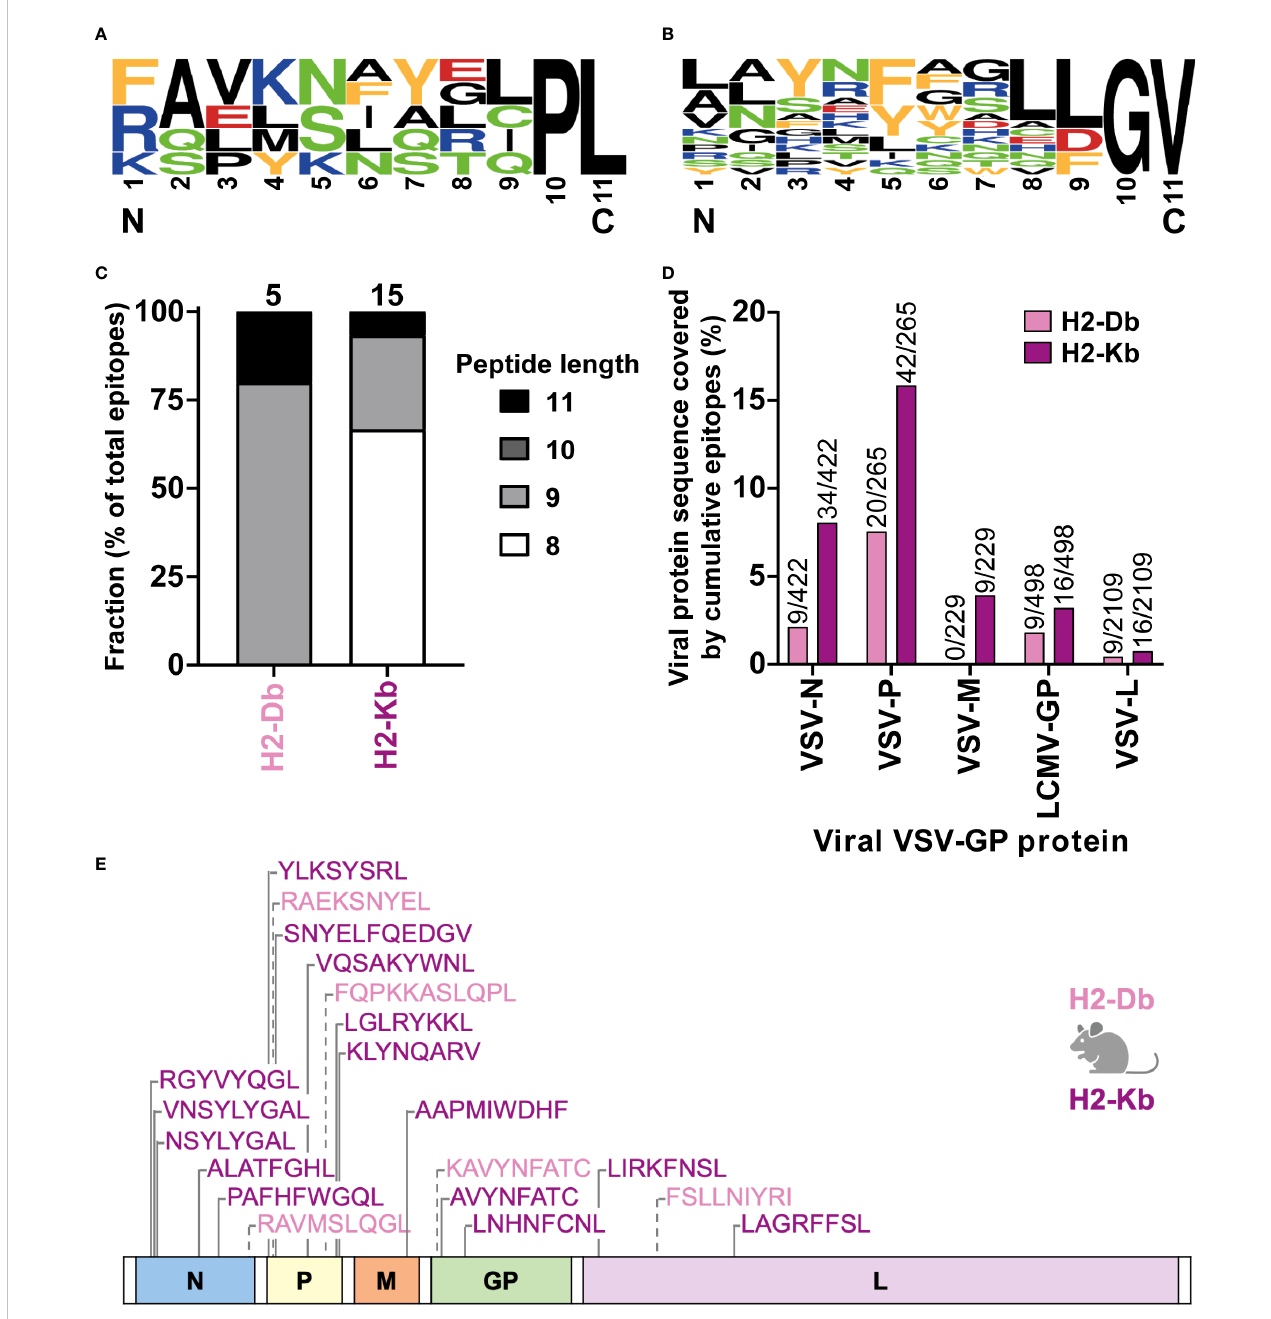
FIGURE 6 H2-Db and H2-Kb presented VSV-GP T cell epitopes differ in peptide sequence logos, peptide length, and viral protein immunogenicity but not in distribution across VSV-GP proteome. (A, B) Sequence logos of fi ve H2-Db presented VSV-GP epitopes (A) and fi fteen H2-Kb presented VSV-GP epitopes (B) . Letter size indicates the frequency of the AA at that position. Positively charged AAs are indicated in blue, negatively charged AAs in red, aromatic AAs in yellow, polar AAs in green, and non-polar AAs in black. (C) Relative distribution of peptide lengths plotted per MHC-I allele for all identi fi ed VSV-GP T cell epitopes. Numbers above bars represent total identi fi ed epitopes per MHC-I allele. (D) Viral protein sequence covered by the identi fi ed epitopes. Numbers above bars represent summed AAs covered by identi fi ed epitopes divided by the viral protein AA length. (E) Schematic overview of the VSV-GP T cell epitopes in the VSV-GP proteome. The epitope sequences have been indicated per MHC-I allele tested (H2-Db in pink, H2-Kb in purple) and their position in the VSV-GP